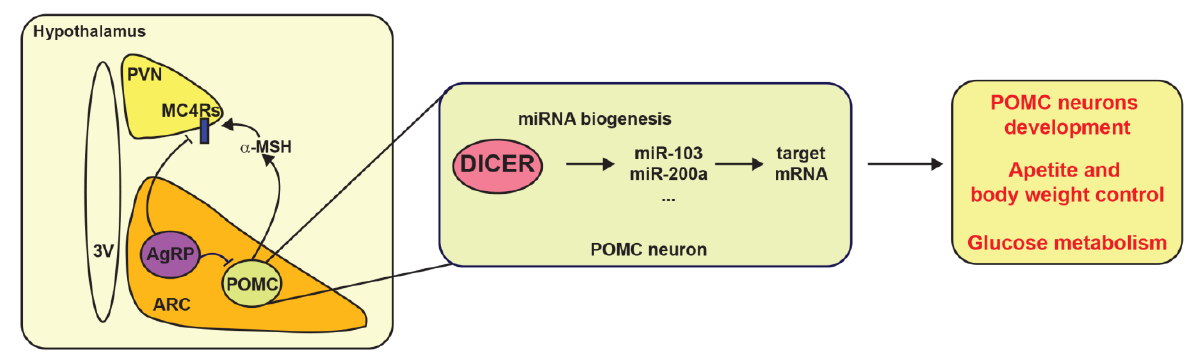
FIGURE 3: Hypothalamic miRNAs control energy balance. POMC and AgRP neurons from the arcuate nucleus (ARC) send projections to the paraventricular nucleus (PVN) to control energy balance. Dicer and several miRNAs, such as miR-103 and miR-200a, have been pro- posed to control appetite and body weight likely via POMC neurons. Additionally, miRNA biogenesis is also important for the development of POMC neurons. Melanocortin receptor 4